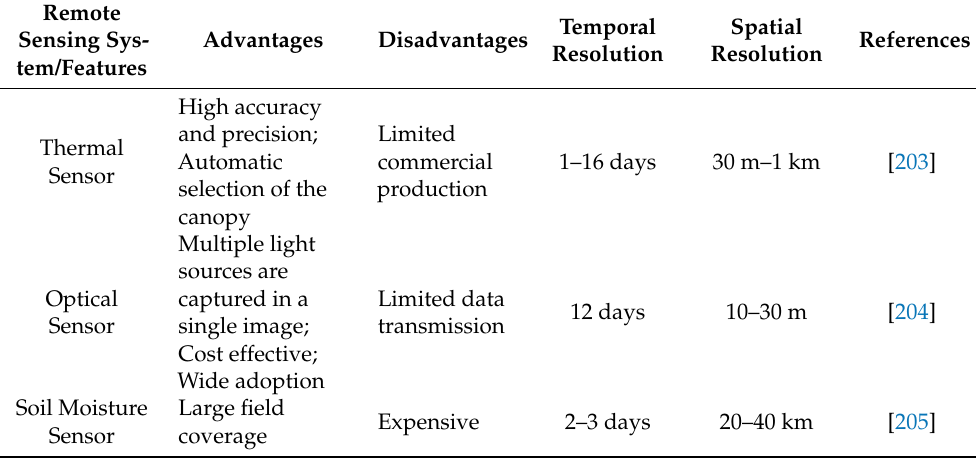
Table 2. Summarizing a few remote–sensing systems and presenting relevant